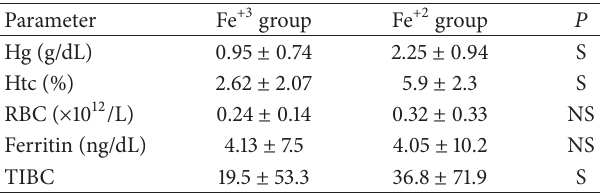
Table 3: Pre- and posttreatment laboratory values between the